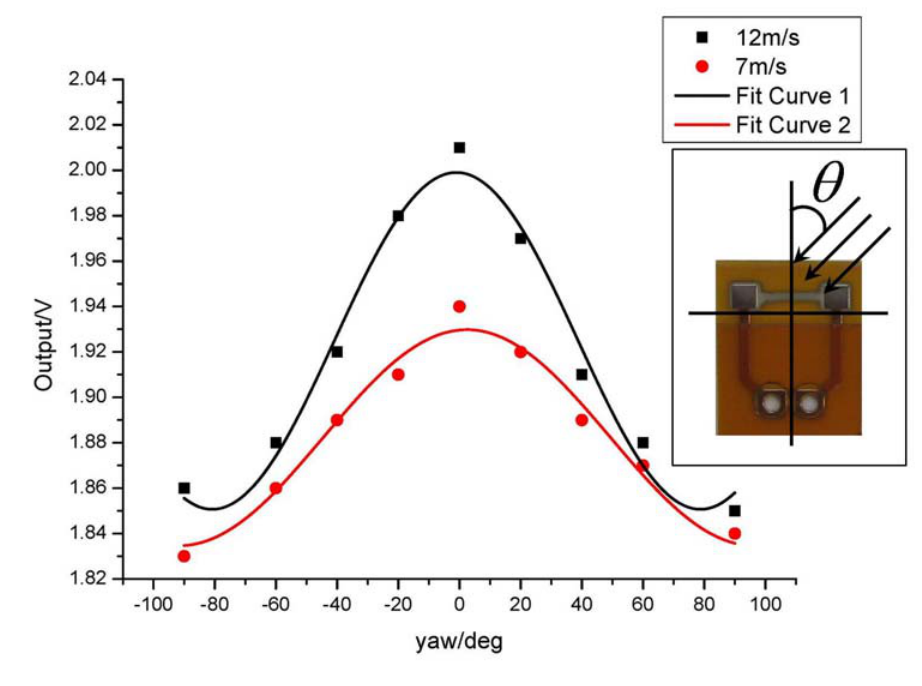
Figure 7. Angular responses under different flow